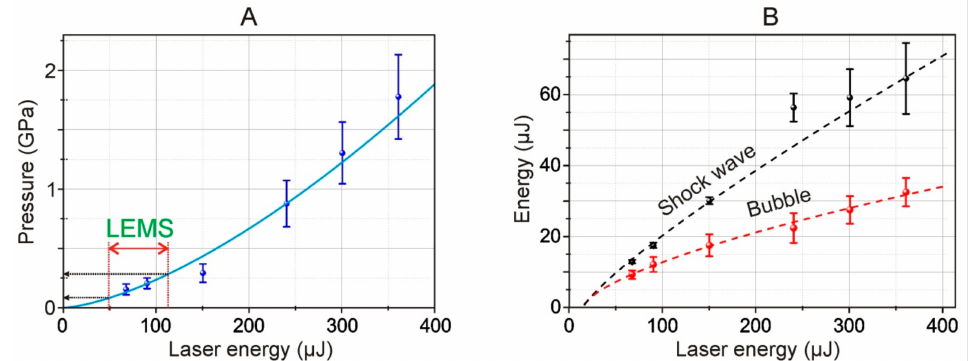
Figure 8. Dependencies of the shock wave pressure ( A ) and the energies ( B ) of a shock wave and a cavitation bubble arising in water from laser energies when a laser pulse duration of τ = 8 ns is applied to an absorbing Ti layer in Configuration 2 (Figure 1B). The blue line in Figure 8A shows trend 1.5 · 10 − 4 · E 1.5 . The dotted lines in Figure 8B show the corresponding trends 0.4 · ( E − 20) 0.83 for the bubble and 0.59 · ( E − 20) 0.65 for the shock wave. Figure 8A highlights the area corresponding to the operating range of fluences for LEMS technology. The vertical dotted arrows limit the range of pressure jumps that can be generated in LEMS